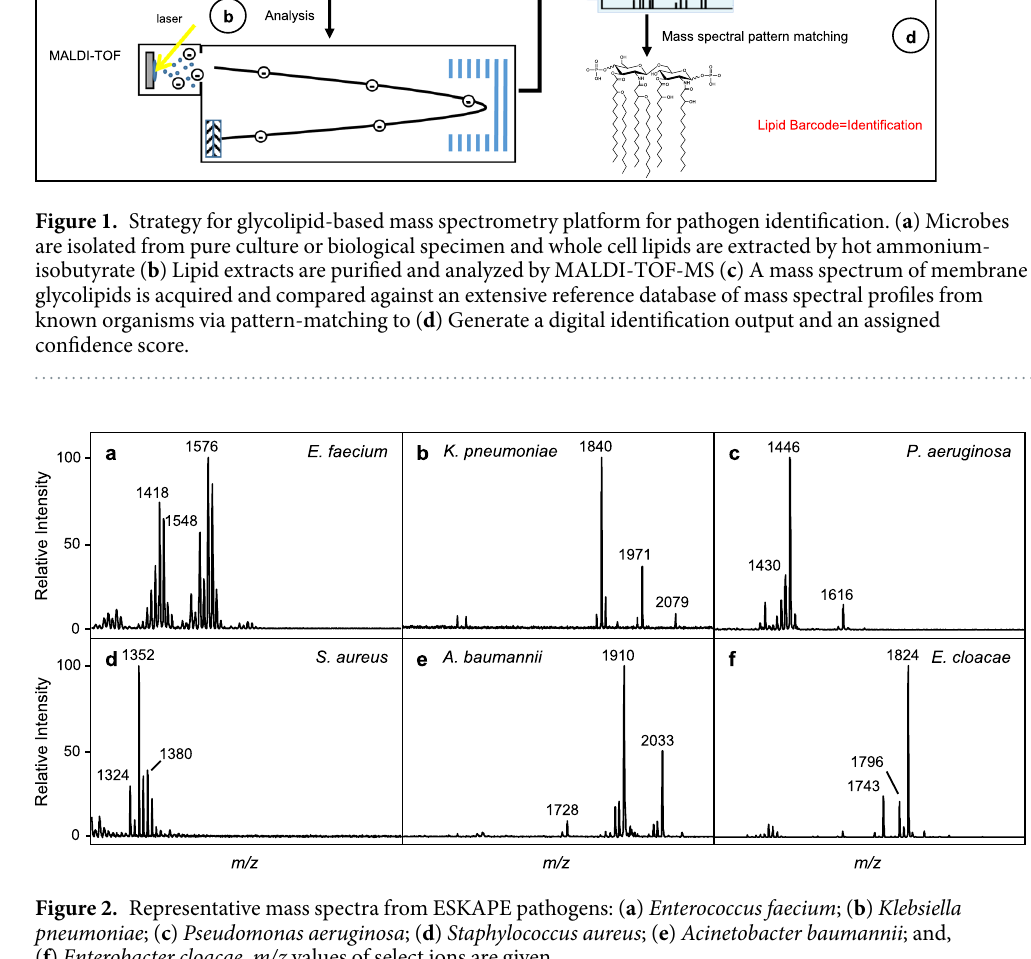
Lipid extraction and MALDI-TOF-MS reproducibility.